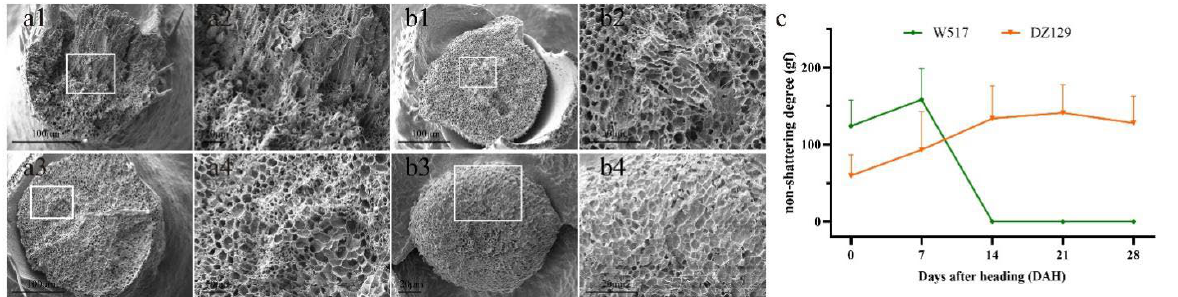
Figure 3. Scanning electron microscopy of tomographic sections of the rice AZ: ( a1 – a4 ) The tomo- graphic SEM of DZ129’s AZ; the fault plane of ( a1 , a2 ) on 0 DAH, and the fault plane of ( a3 , a4 ) at 28 DAH. ( b1–b4 ) The tomographic SEM of W517’s AZ; the fault plane of ( b1 , b2 ) on 0 DAH, and the fault plane of ( b3 , b4 ) on 14 DAH. Scale bars: a1, a3, and b1 are 100 μm; a2 and a4 are 10 μm; b2, b3, and b4 are 20 μm. ( c ) Comparison of DZ129 and W517 BTS values at 0, 7, 14, and 28 DAH. Values are means ± SDs (n = 40 grains).